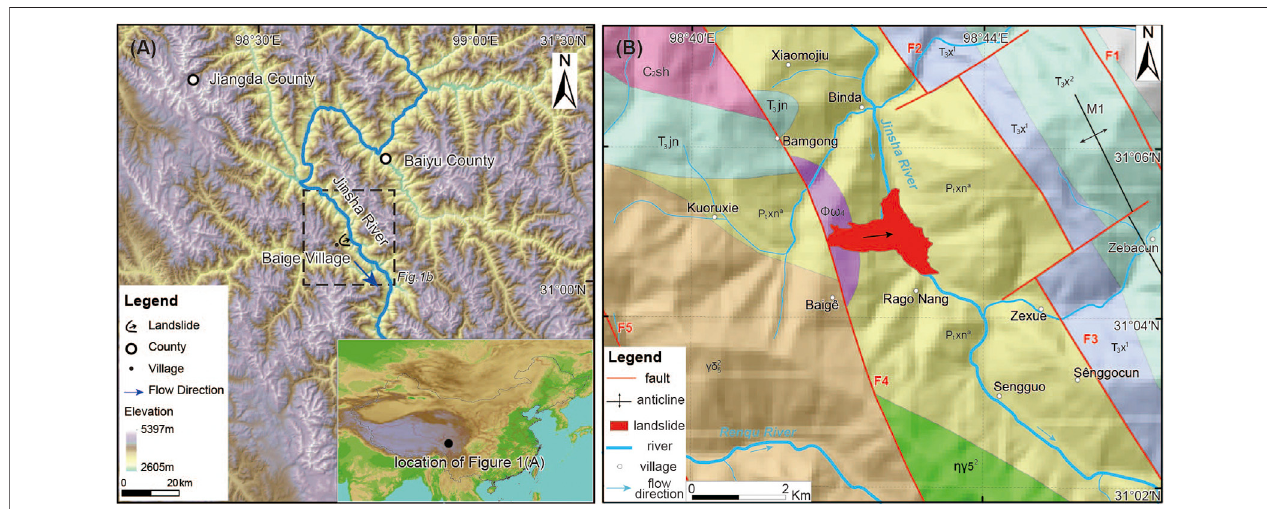
FIGURE1| TopographicandgeologicmapsofBaigelandslide (A) Topographicmap(TheinsertshowsthelocationofthestudyareainChina). (B) Geologicalmap (modi fi edfromFanetal.,2019).F1:Xuenqing-LonggangFault;F2:Zhuying-GondaFault;F3:Zeba-XietangFault;F4:Boluo-MuxieFault;F5:Gangda-DizhongFault;M1: Shandong-Baba Anticline; T 3 jn: Upper Triassic Jingu Formation; T 3 x 2 : Upper Segment of Upper Triassic Xianisongduo Formation; T 3 x 1 : Lower Segment of Upper Triassic Xianisongduo Formation; C 2 sh: Upper Carboniferous Shengpa Formation; P t xn a : Upper Proterozoic Xiongsong Group Gneiss Formation; φω 4 : Late Paleozoic Variscan Jinshajiang ultrama fi c belt and serpentinite; η γ 5 2 : Yanshanian Gepo superunit fi ne grained monzonitic granite; γ δ 52 : Yanshanian Zeba superunit Muzha fi ne-grained granodiorite and quartz diorite.